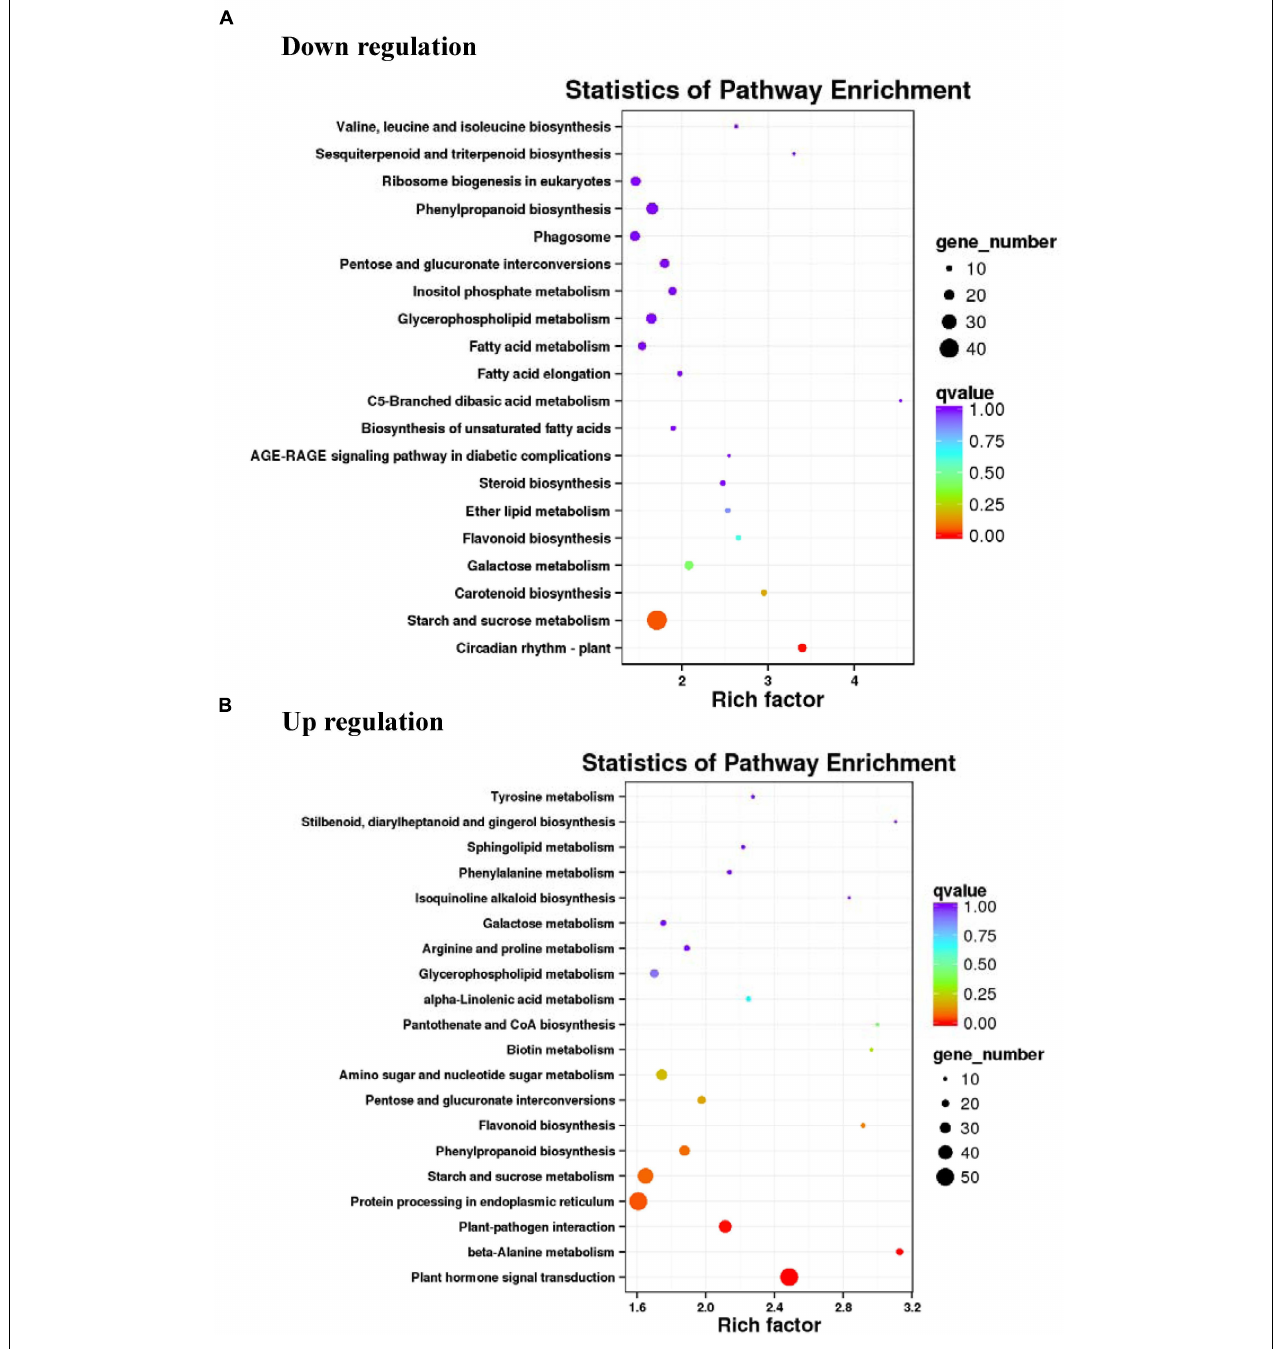
FIGURE 4 | Kyoto Encyclopedia of Genes and Genomes (KEGG) pathway analysis of differentially expressed genes (DEGs) in RNA-seq. Top 20 pathways were characterized among the upregulated (A) and downregulated (B) DEGs.